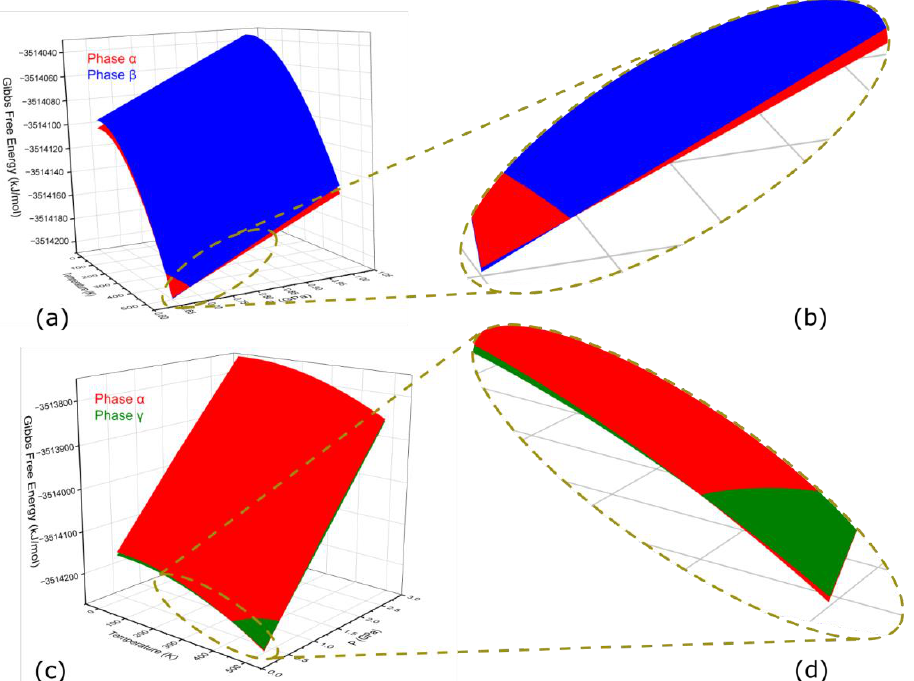
Figure 4. The effects of pressures and temperatures on Gibbs free energies (GFEs). Sub-figure ( a , c ) show a 3D surface plot of phases α , β , and α , γ , respectively. Sub-figure ( b , d ) show magnified portions of sub-figure ( a , b ), respectively. The red, blue, and green colors represent the phases α , β , and γ, respectively.